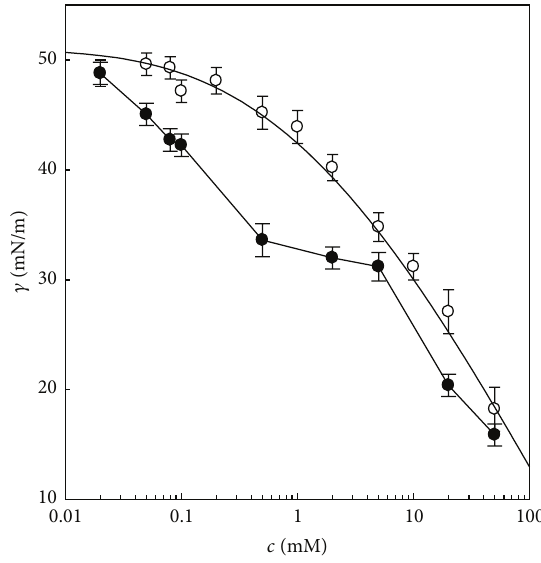
Figure 3: Dependences of the surface tension of the water/hexane interface on the PA concentration: PA ( I , the solid lines represent the fitting of the experimental data to the Frumkin adsorption isotherm) and silica nanoparticles-PA mixtures ( e ). The particle concentration in the bulk was 1 wt%. Reproduced from [49], Cop- yright 2014, with permission from